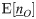
Intra-cluster spatial gradients in spark probability are characterized by one or two eigenmodes.Data are shown for 10 clusters obtained from STED microscopy. (A) Spatial gradients in E[n¯O]. (B) Fractional eigenmode contributions to E[N
O] corresponding to the 10 greatest eigenvalues of the adjacency matrix. (C) Dominant eigenmode (b1v¯1) corresponding to λ
1. (D) Subdominant eigenmode corresponding to the second greatest b
i. Negative values shown as 0 for clarity. (E) Correlation coefficients between the values of E[n¯O] from panel (A) and the (1) dominant eigenmode, (2) sum of dominant and subdominant eigenmodes, and (3) sum of dominant, subdominant, and tertiary eigenmodes. Color scales in all panels are the same as in Fig 4D.